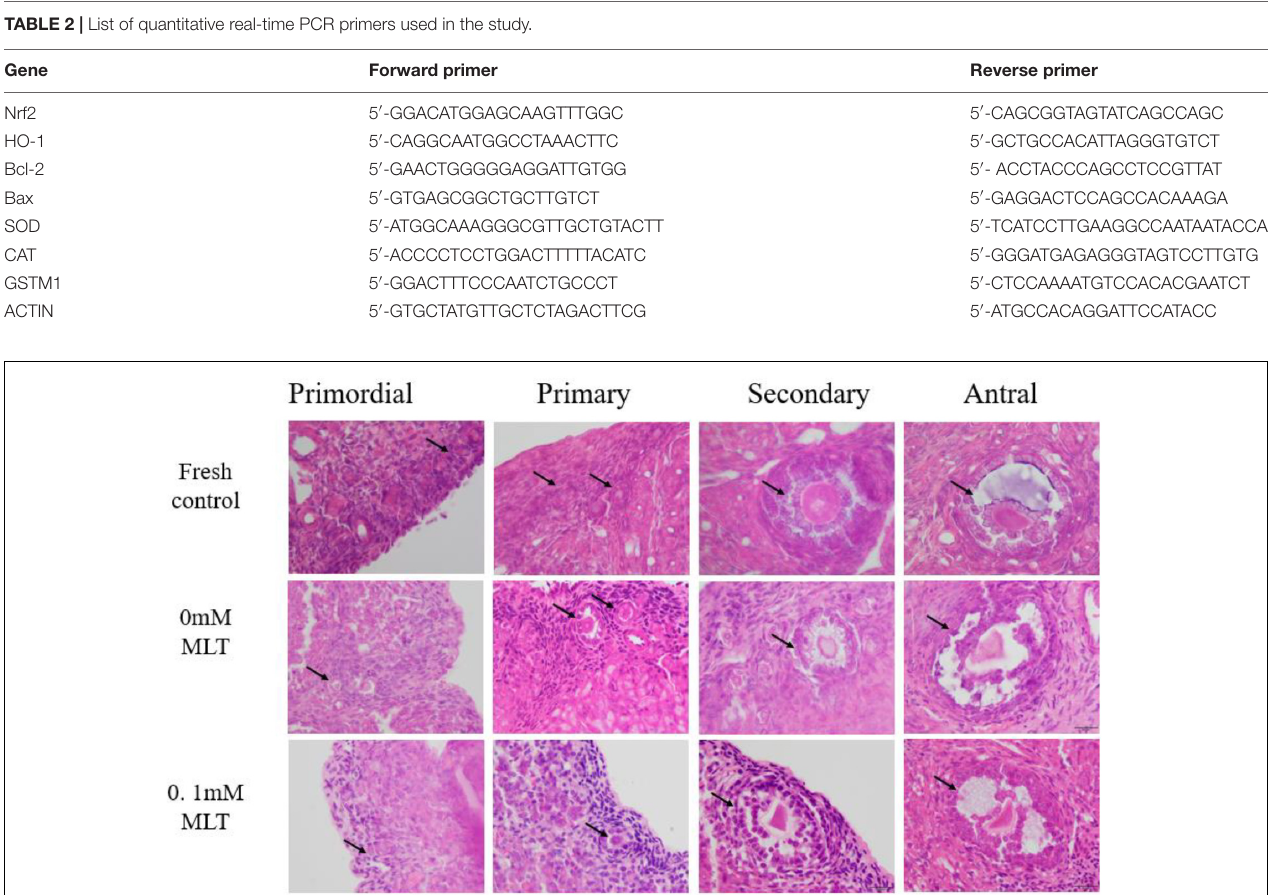
FIGURE 1 | MLT protected the morphological integrity of follicles at various developmental stages in cryopreserved OTs. The horizontal panel represents the developmental stage of follicles. The vertical panel represents three groups (fresh, 0 mM, and 0.1 mM), respectively.